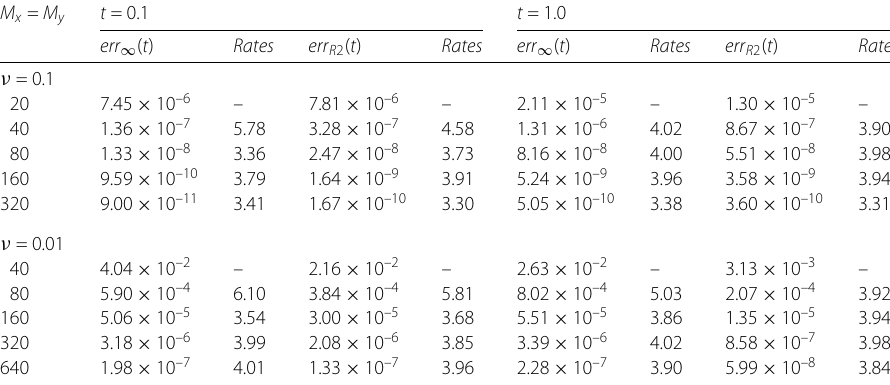
Table 2 Spatial convergence rate for Example 2 with fixed h = 0.00002